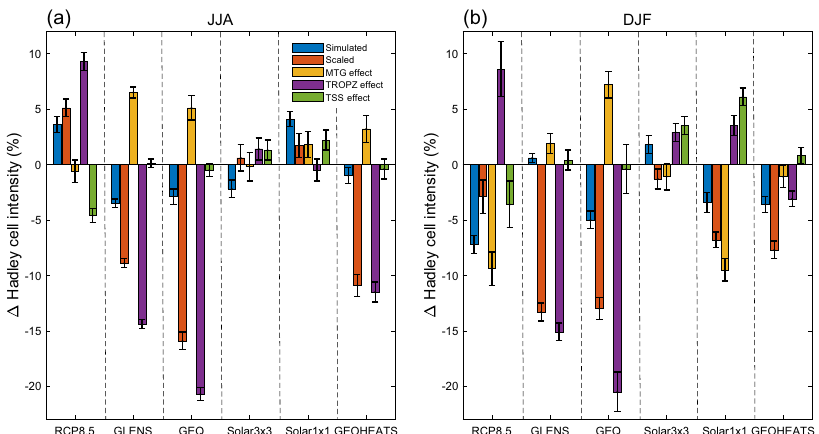
Fig. 3 Changes in simulated and scaled Hadley cell intensity. JJA average ( a ), and DJF average ( b ) ensemble mean percentage changes in winter simulated Hadley cell intensity, scaled HC intensity based on Held 13,15 , and the effect from each component on the right-hand side of the Eq. 2 under RCP8.5, GLENS, GEQ, Solar3x3, Solar1x1 ensemble mean (during 2075 – 2095) and GEOHEATS ensemble mean relative to the baseline ensemble mean (RCP8.5 runs during 2010 – 2030), respectively. The HC intensity scaling depends on subtropical tropopause height (TROPZ), meridional potential temperature gradient (MTG), and tropical static stability (TSS). To isolate the effect of one component in a perturbation, the other components are set to the baseline values in Eq. 2. Error bars represent standard error. HC intensity is de fi ned as the vertical average of the maximum zonal mean ψ m between 900 and 200 hPa, see Nguyen et al. 57 for details on the calculation. Since the winter HC is stronger than summer, we only focus on changes in the winter HC intensity, for both hemispheres. Therefore, the analyses are performed on DJF for the Northern Hemisphere and JJA for the Southern Hemisphere